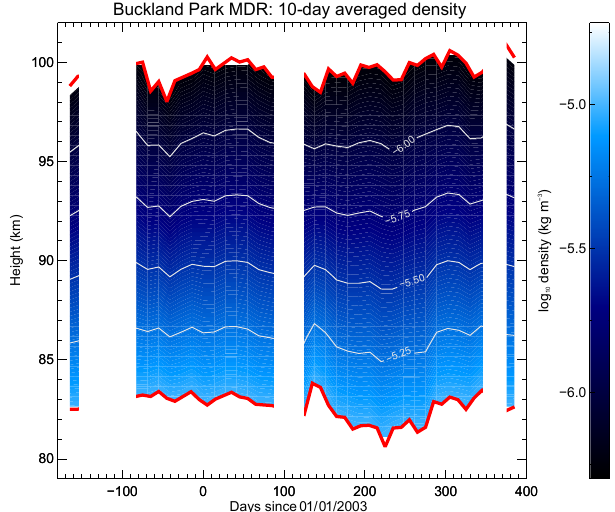
Figure 6. The geometric heights for 10-day average fixed density surfaces for 14 May 2002 to 28 January 2004 determined from the meteor radar. This diagram has been prepared using the difference in the estimate of the geometric height of two constant density sur- faces to calculate the density scale height, H ∗ . The density profile is then interpolated between the two surfaces. Once the density or temperature dependence of the airglow layer is known, the density profile can be used to infer the height to which airglow temperatures